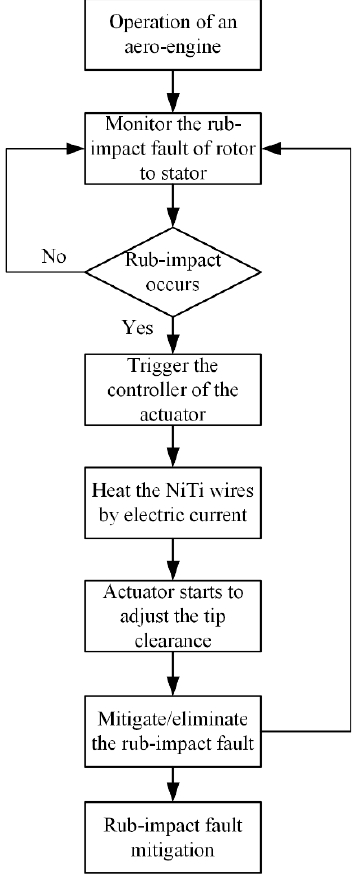
Figure 8. Flowchart of the proposed fault mitigation scheme.